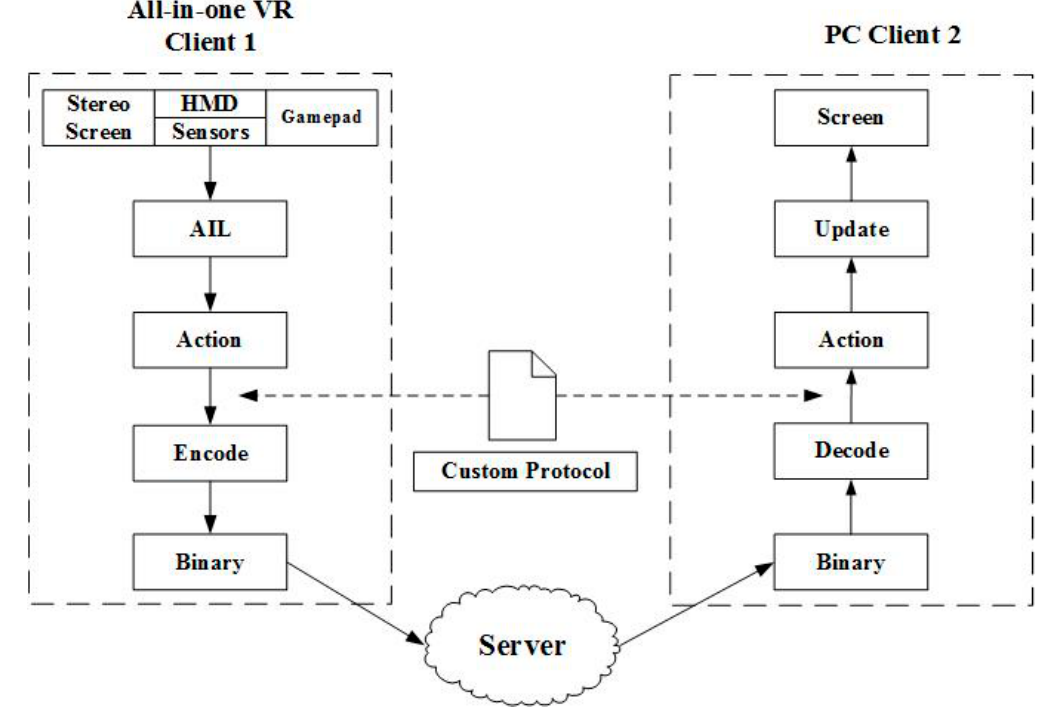
Figure 4. Flow chart of protocol-based interactions for heterogeneous clients.